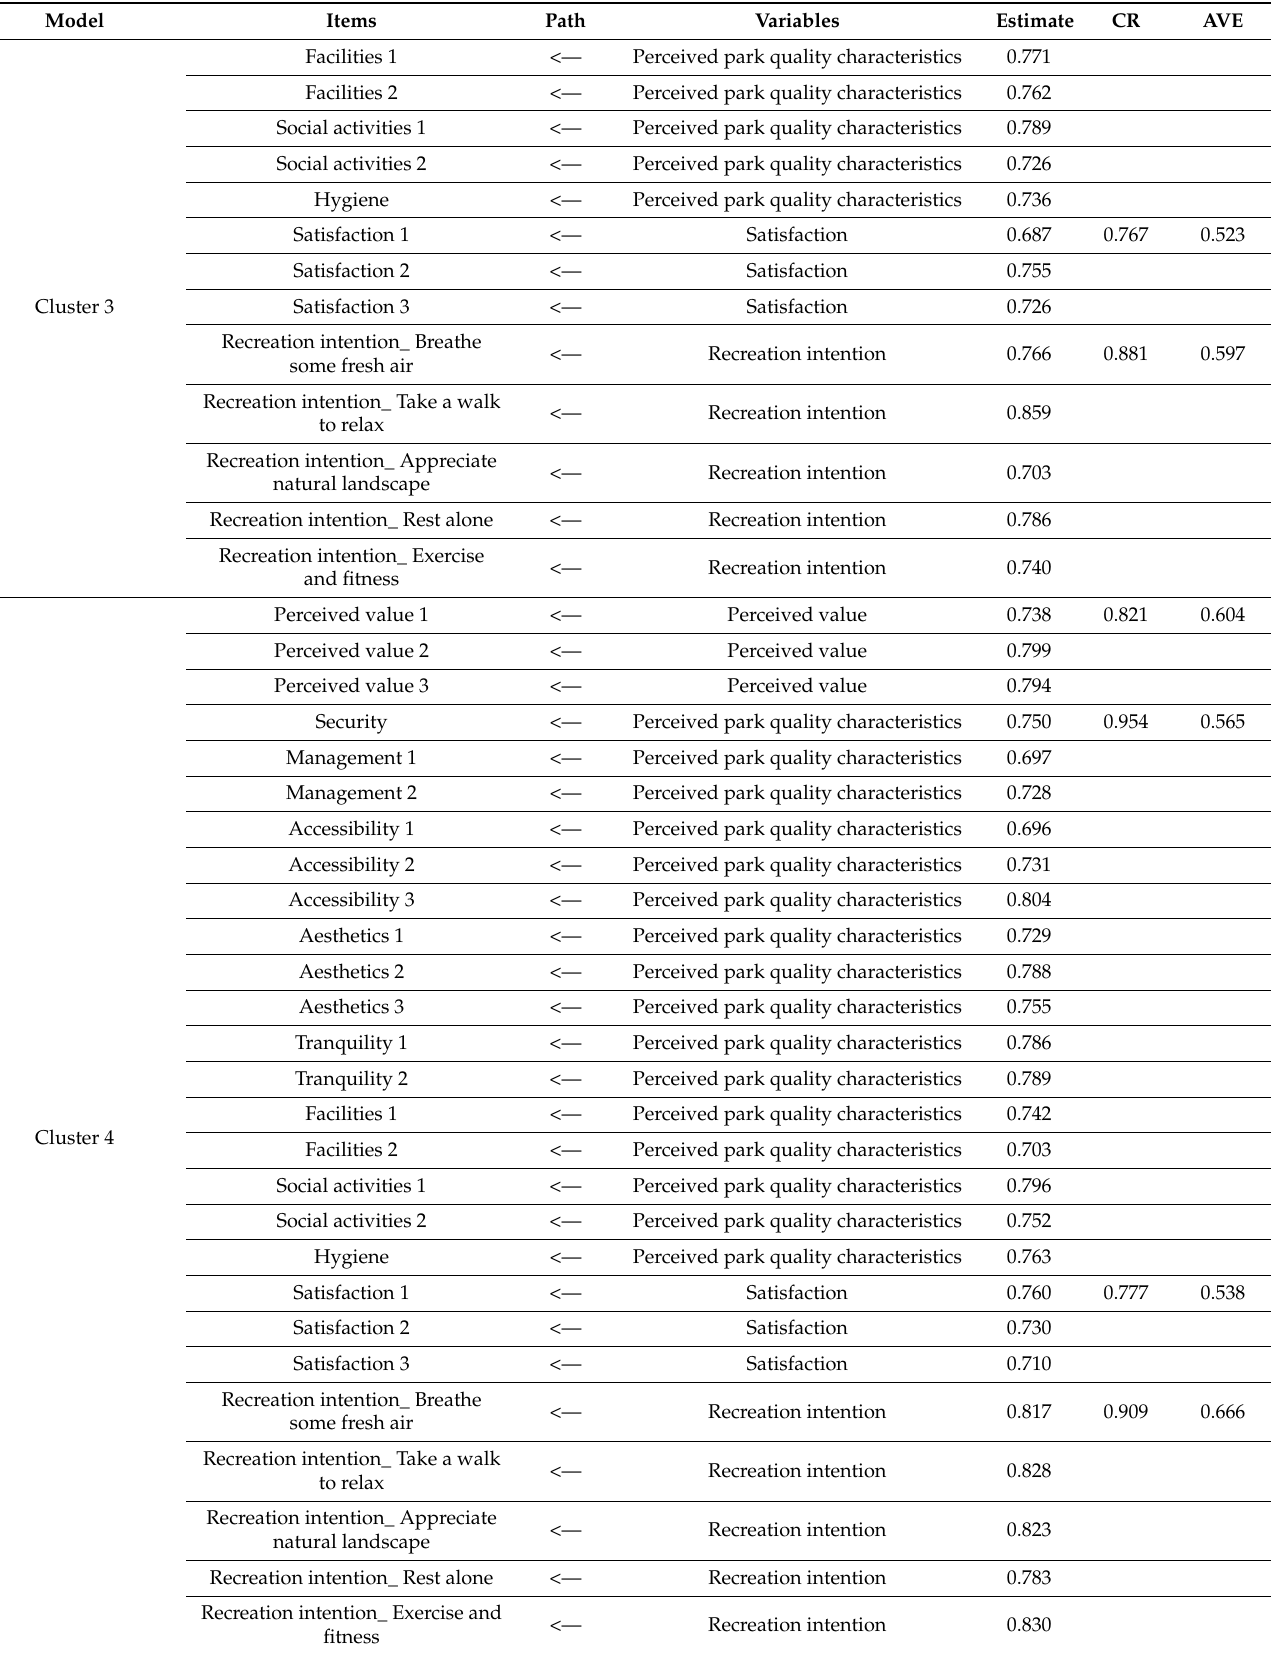
Table A7. Reliability and validity analysis by AMOS.